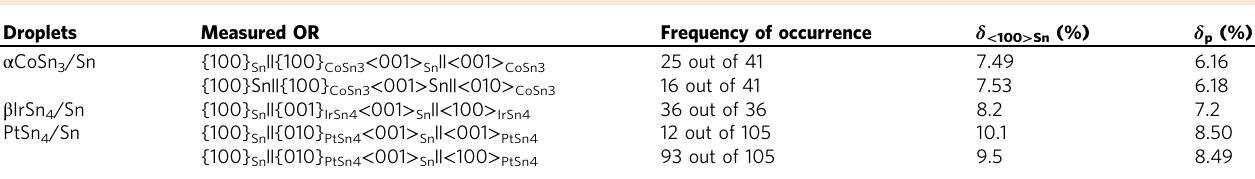
The frequencies of occurrence and disregistries of each OR are also